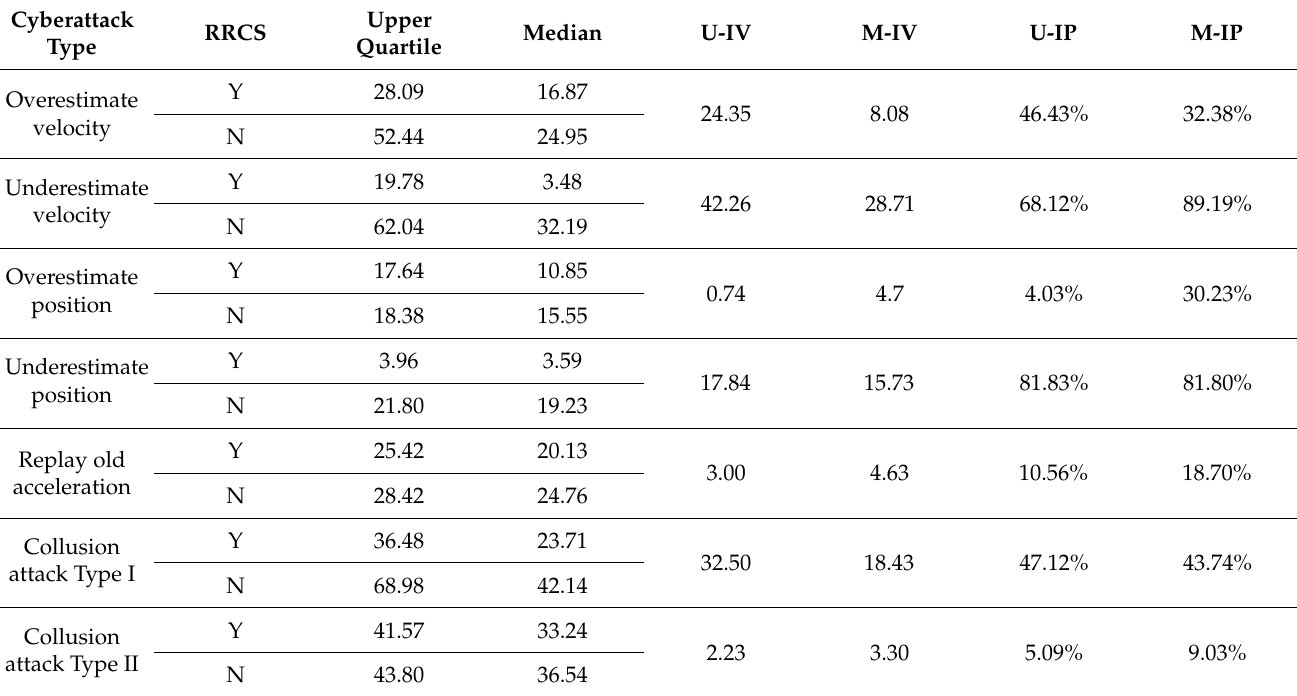
Table 4. Box plot data of variance distribution of headway deviation with or without RRCS under different vehicle proportion and vehicle